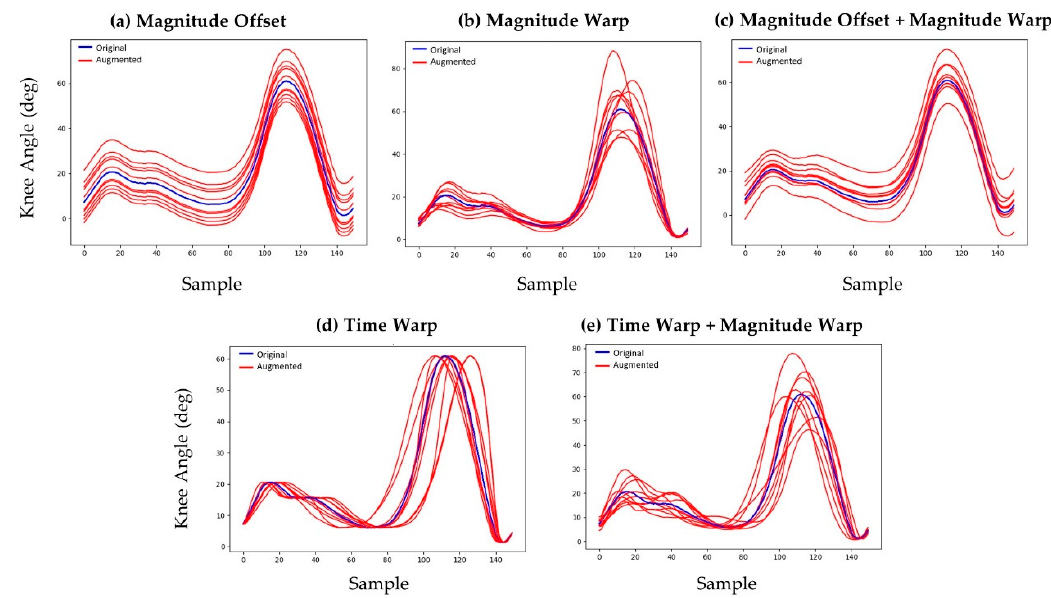
Figure 3. Various data augmentation methods used to generate synthetic kinematic data: ( a ) magnitude offset, ( b ) magnitude warping, ( c ) combined magnitude offset and magnitude warping, ( d ) time warping, and ( e ) combined time warping and magnitude warping.